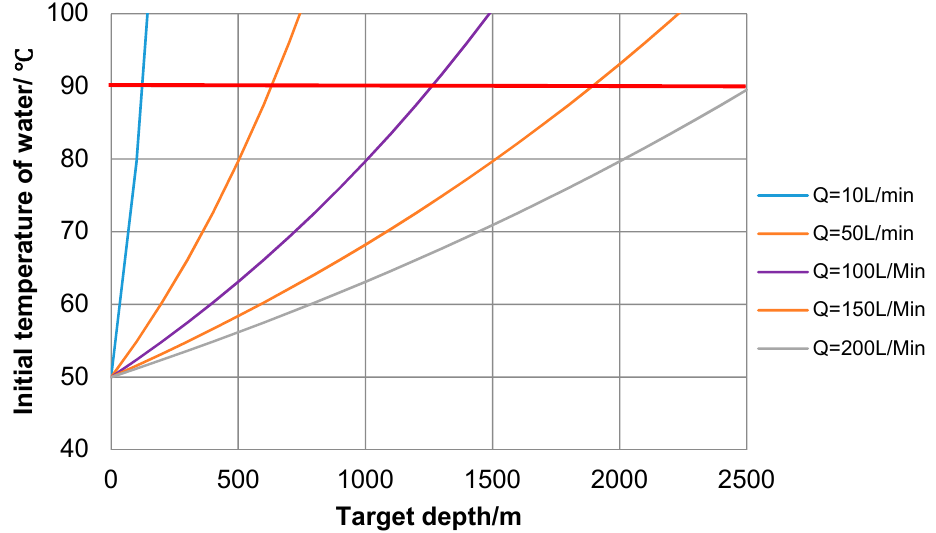
Figure 7. Required initial temperature of hot water vs. target depth at different flow rates of hot water; bottom water temperature is taken constant as 50 ° C ( b = 11 mm, d h = 38 mm, k = 0.3 J s − 1 m − 1 K − 1 , and C w = 4190 J kg − 1 K − 1 ).